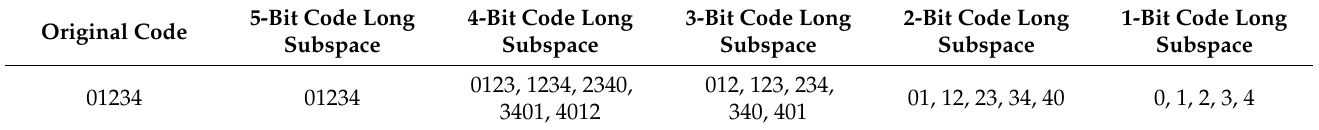
Table 2. Establishment of subcode